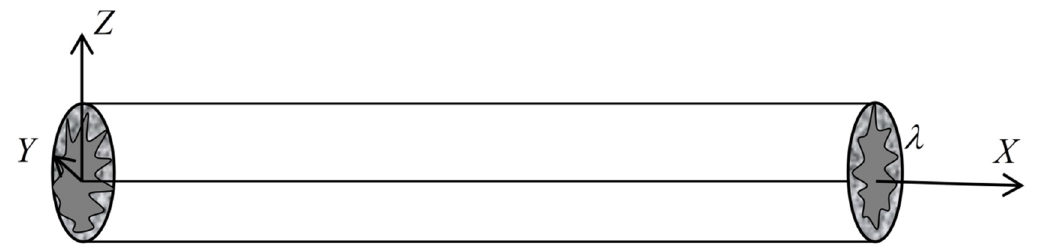
Figure 6. Spatial coordinates of rough straight capillaries.